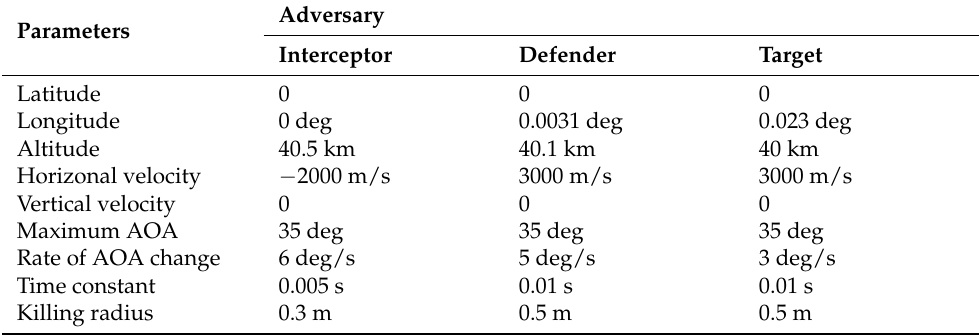
Table 1. Simulation